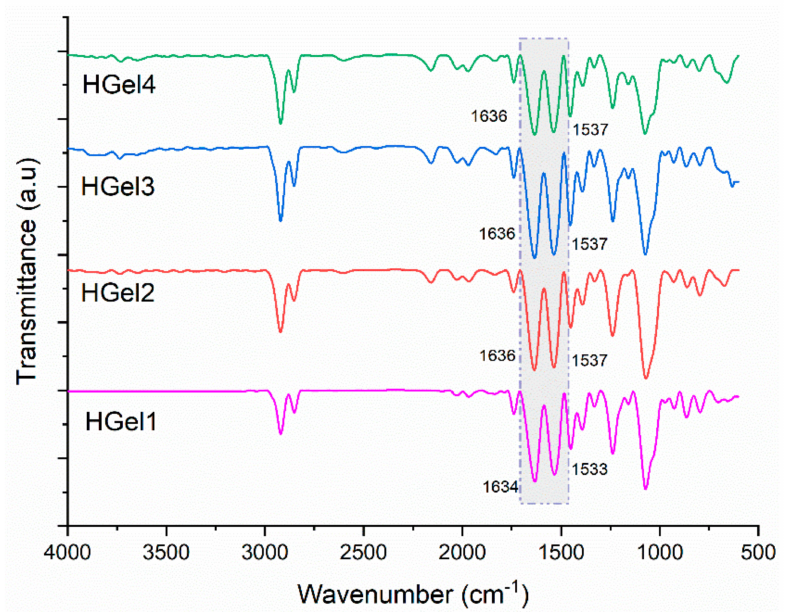
Figure 1. FTIR spectra of gelatin-based hydrogels (loaded with nanogels–HGel2, HGel3 and HGel4 and